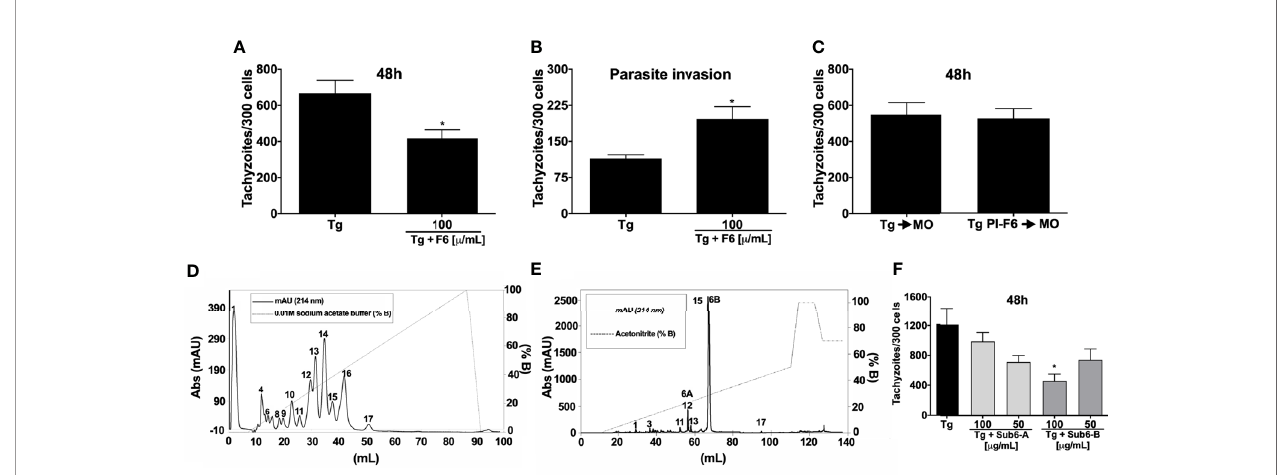
FIGURE 3 | Subfraction Sub6-B from F6 induces potent control of T. gondii replication by macrophages. Peritoneal macrophages were cultured and infected (1:1 parasite: cell ration) and/or stimulated by F6 (100 µg/mL). Intracellular parasite counts were performed on fi xed and stained cells at 48 h (A) or 4 h (B) post-infection/ stimulus. Macrophages were infected with F6 (100 µg/mL)-pre-incubated tachyzoite forms ( “ PI ” ) and the intracellular parasites were quanti fi ed 48 h after infection (C) . Each point represents means ± SEM of one of the two independent experiments,* p ≤ 0.05. For puri fi cation of molecules, fraction F6 was subjected to cation exchange chromatography in which the components were eluted at a fl ow rate of 1 mL/min and peaks detected at 214 nm (D) , and the resulting peak 13 was subjected to reversed-phase chromatography with a fl ow rate of 1 mL/min and detection at 214 nm, followed by MALDI-TOF mass spectrometry and Edman degradation analyses, resulting in subfractions listed from 1 – 17 (E) . The infected-macrophages were stimulated with homogeneous molecules (toxins): Sub6-A (peak 12) or Sub6-B (peak 15) (100 or 50 µg/mL). Intracellular parasite growth was analyzed on fi xed and stained cells at 48 h post-infection/stimulus (F) . Each point represents means ± SEM of one experiment, * p ≤